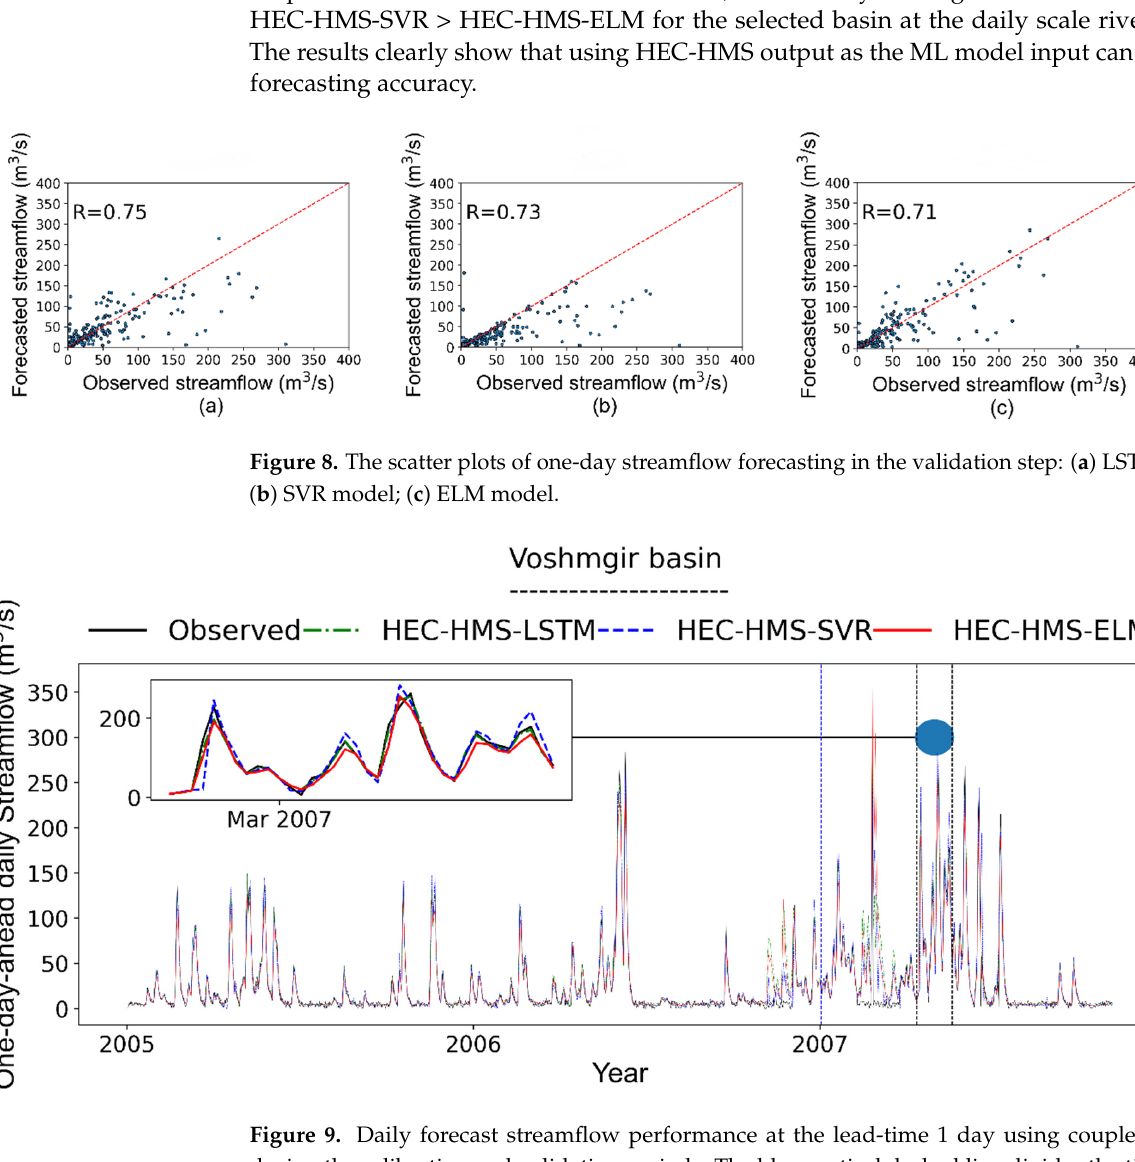
Figure 9. Daily forecast streamflow performance at the lead-time 1 day using coupled models during the calibration and validation periods. The blue vertical dashed line divides the time series into calibration and validation periods. A zoom-in of the blue circle area investigates the model’s performance in March 2007.